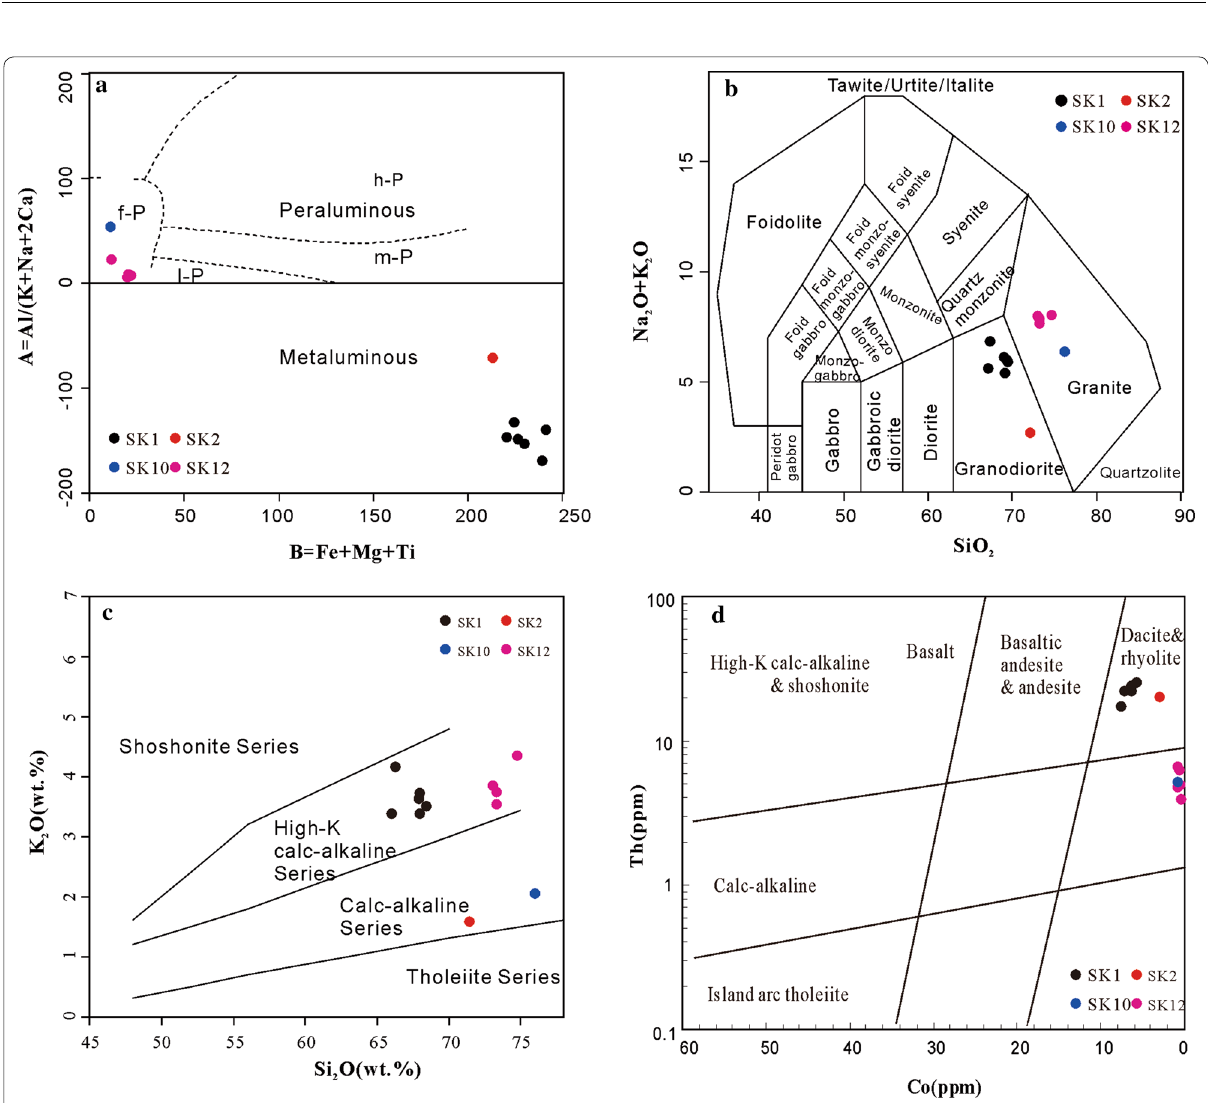
K 2 O versus SiO 2 is from +